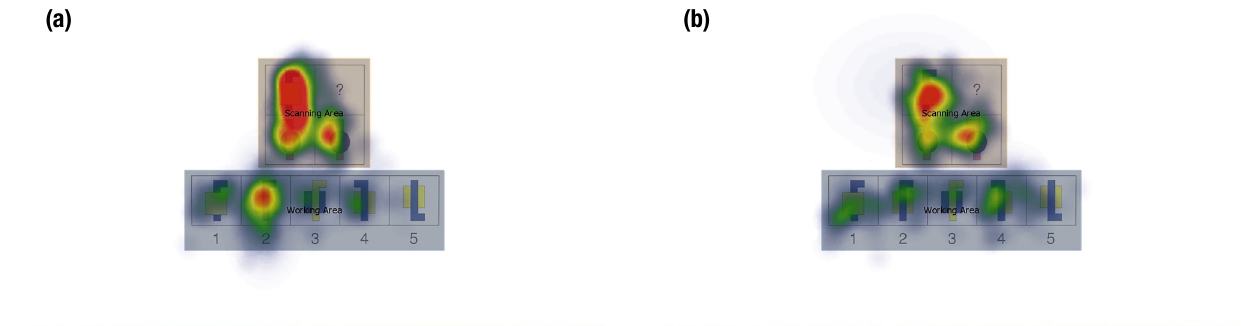
Figure 1. Heat maps of the fixations by the correct (a) and incorrect (b)